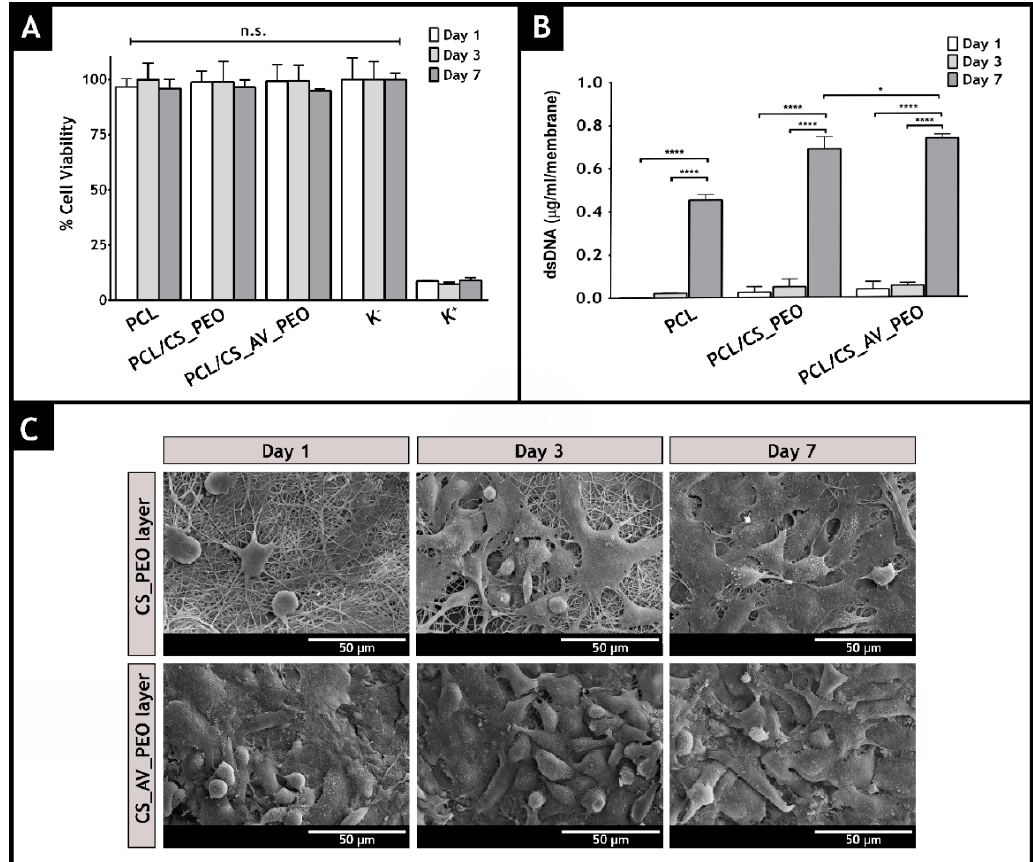
Figure 7. Characterization of the biological performance of the produced membranes. NHDF cell viability was evaluated when the cells were incubated with produced membranes ( A ) and the content of dsDNA of NHDF cells adhered to the surface of the developed membranes was determined after 1, 3, and 7 days of incubation. The statistical analysis of the results was performed using one-way ANOVA with Newman–Keuls test ( B ); SEM micrographs of NHDF cells morphology at the surface of the different electrospun membranes after 1, 3, and 7 days are presented in ( C ).